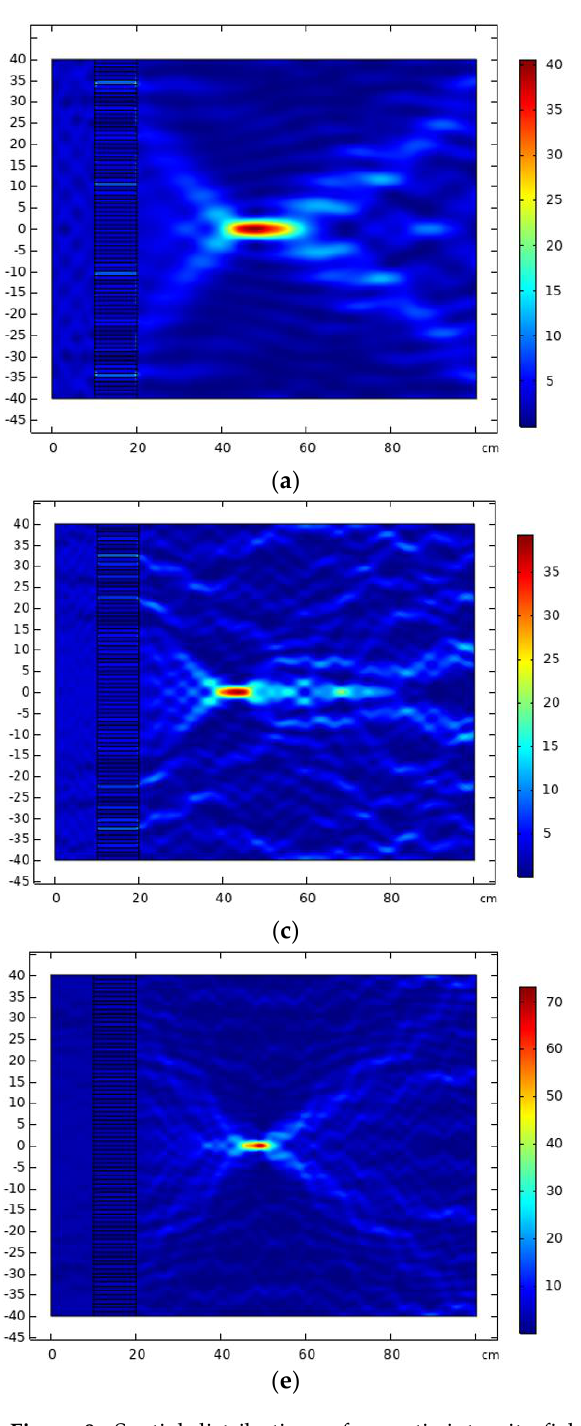
Figure 9. Spatial distributions of acoustic intensity field through focusing lens at ( a ) 28 kHz, ( b ) 35 kHz, ( c ) 40 kHz, ( d ) 45 kHz, (e) 50 kHz, and (f) 55 kHz.